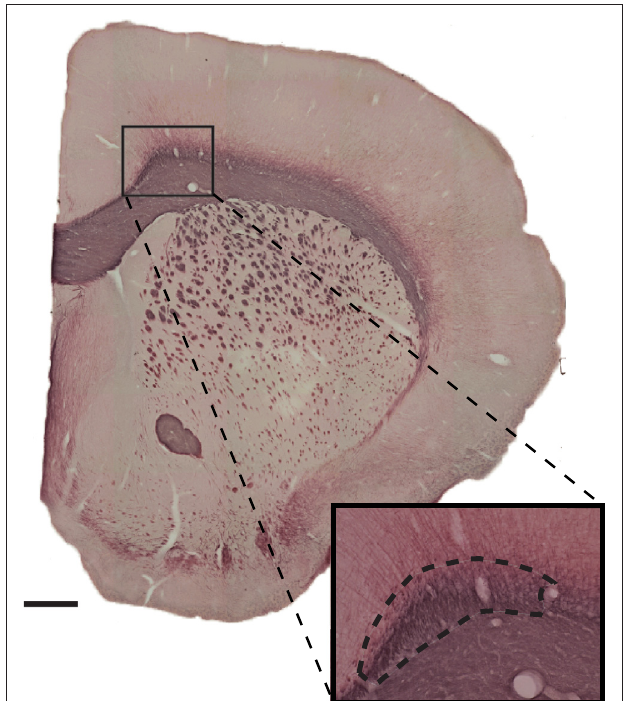
FIGURE 5 | Low magnifi cation photomicrograph of a myelin Black Gold stain of a wild-type mouse. Inset depicts the outlined cingulum bundle for analysis of fi ber length density. Scale bar 50